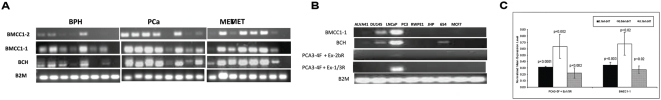

PCA3 and BMCC1-1 expression patterns in prostate cancer.cDNA was prepared from patient tissue specimens including eight BPH, PCa or PCa metastases, respectively, for use in the following PCR reactions. (A). RT-PCR carried out on BPH, PCa and metastases (MET) with different sets of primers for PCA3 and BMCC1 Upper row; BMCC1-2 RT-PCR using a forward primer for BMCC1 exon 5 (BMCC1-Ex5F) and a reverse primer specific for the extended form of exon 6 (BMCC1-Ex7R) unique to BMCC1-2 2nd row; BMCC1-1 specific RT-PCR using primers for BMCC1 exon 6 (BMCC1-Ex6F) and exon 7 (BMCC1-Ex7R). 3rd row; BMCC1-BCH region specific RT-PCR using primers BCHF and BCHR. 4th row; PCA3 was amplified (35 cycles) with primers specific to PCA3 isoform 5 exon 1 (PCA3-5F and the Ex1/3R primer). 5th row; β2microglobulin control PCR (B). RT-PCR comparative expression analysis of PCA3, BMCC1-1 and the BMCC1-BCH region for ALVA41, DU145, LNCaP and PC3 prostate cancer lines, RPWE1 a normal prostate cell line, JHP a control lymphoblastoid cell line, RM654 a lymphoblastoid cell line from a patient with AOA2 and MCF7 a breast cancer cell line. RT-PCR was carried out with the primer sets specific for PCA3 isoform 5 (PCA3-5F) and Exon 1/3 (Ex1/3R) and for BMCC1-1 and the BMCC1-BCH region as indicated above. (C) Semi-quantitative PCR analysis of PCA3 and BMCC1-1 expression in the LNCaP cell line in response to dihydrotestosterone. Results were normalised relative to levels of β2microglobulin. Four cell cultures were starved of serum for 2 days prior to incubation with dihydrotestosterone (µg/ml). Results were normalised and expressed as mean fold increase relative to the level of expression before treatment. Error bars are standard deviations and p values were determined from comparison with untreated samples using a Student's t-test.